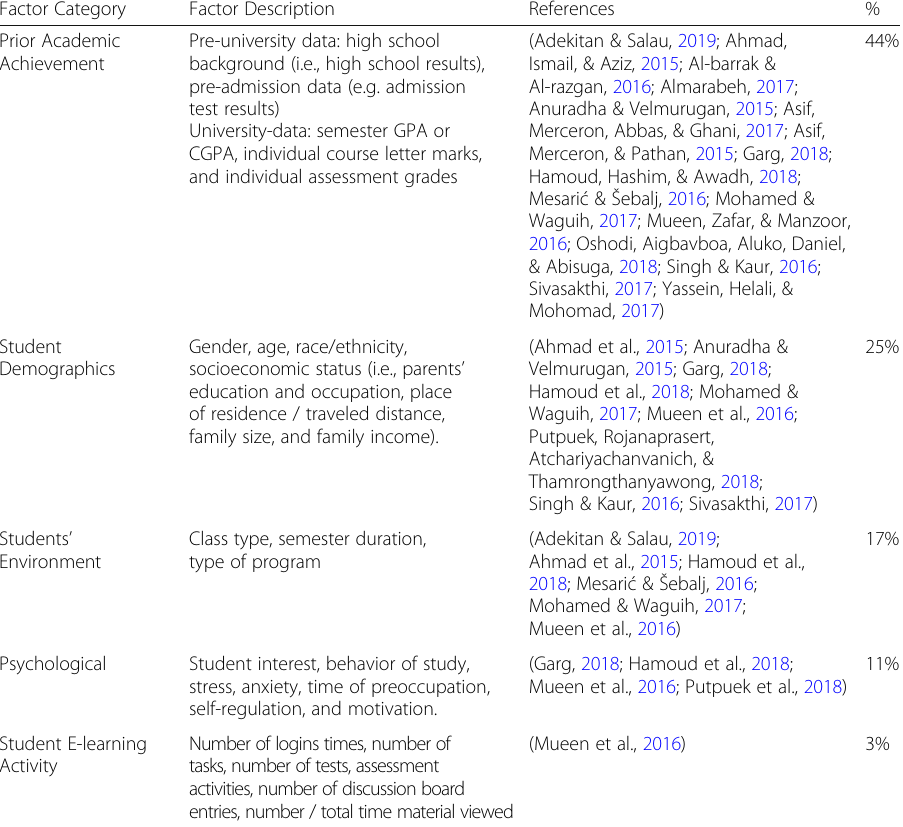
Table 1 Most influential factors on the prediction of students ’ academic success Factor